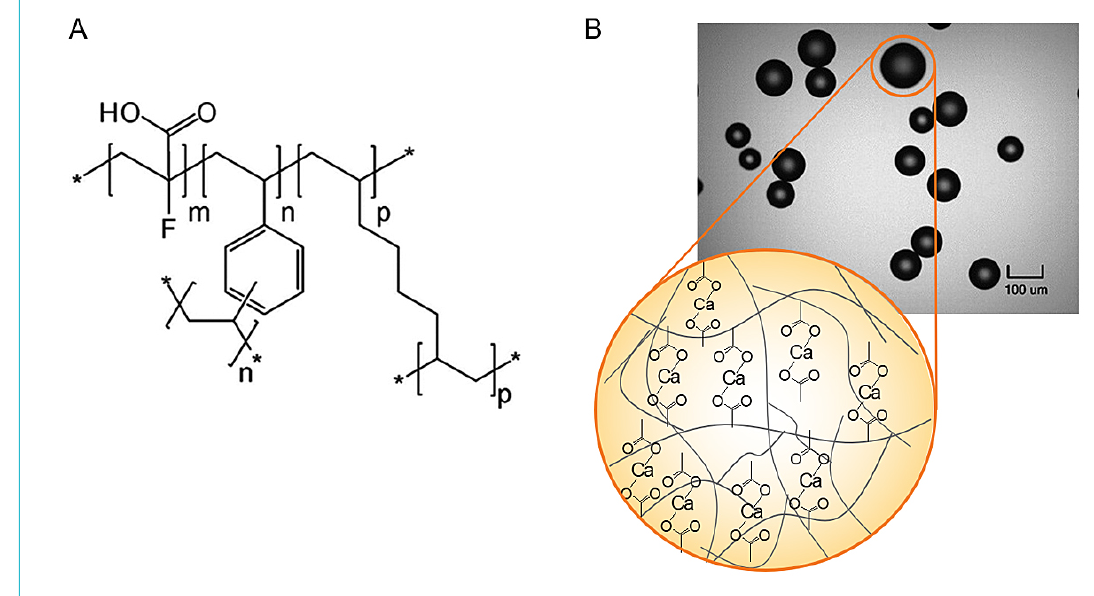
Figure 2: Structure of the novel potassium binder patiromer.A. Chemical structure of patiromer anion (m indicates number of 2-fluo- ro-2-propenoic acid groups; n, p, indicate number of cross-linking groups. *An extended polymeric network.B. Light microscopy images (×100 magnification) of patiromer. Adapted with the permission of SAGE from: Li L, et al. J Cardiovasc Pharmacol Ther.